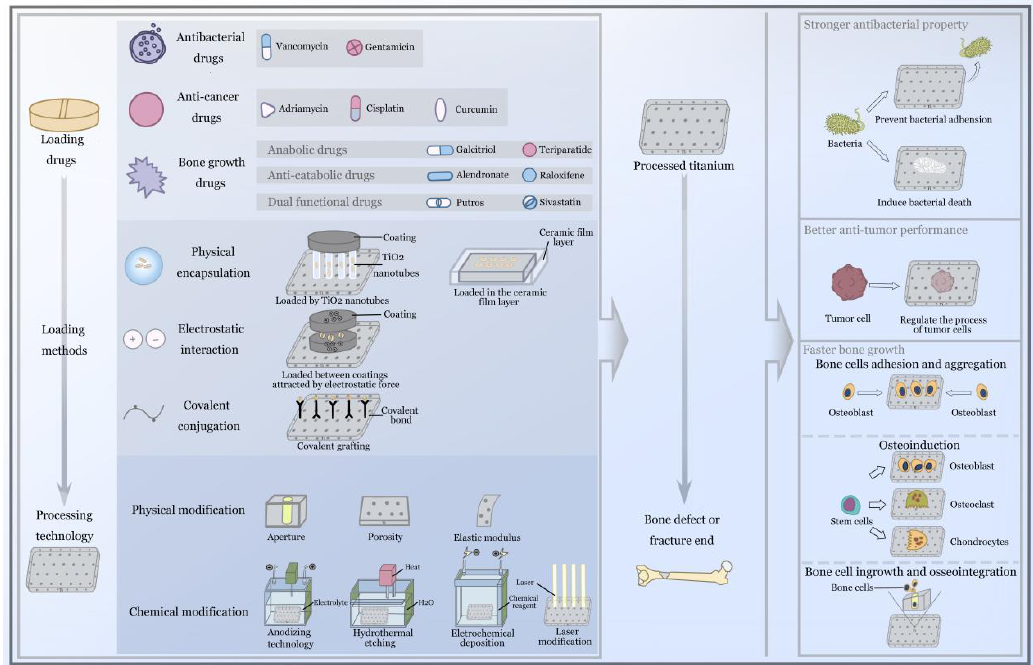
Figure 1. Schematical presentation of local drug delivery system on a titanium implant modified by metal processing technology, and the excellent advantages after implantation.